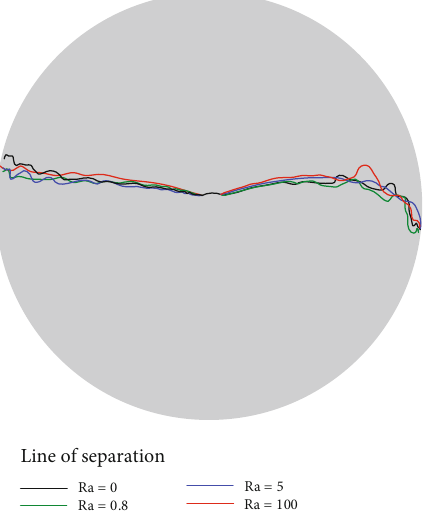
Figure 26: Comparison of separation lines with di ff erent roughness values on both